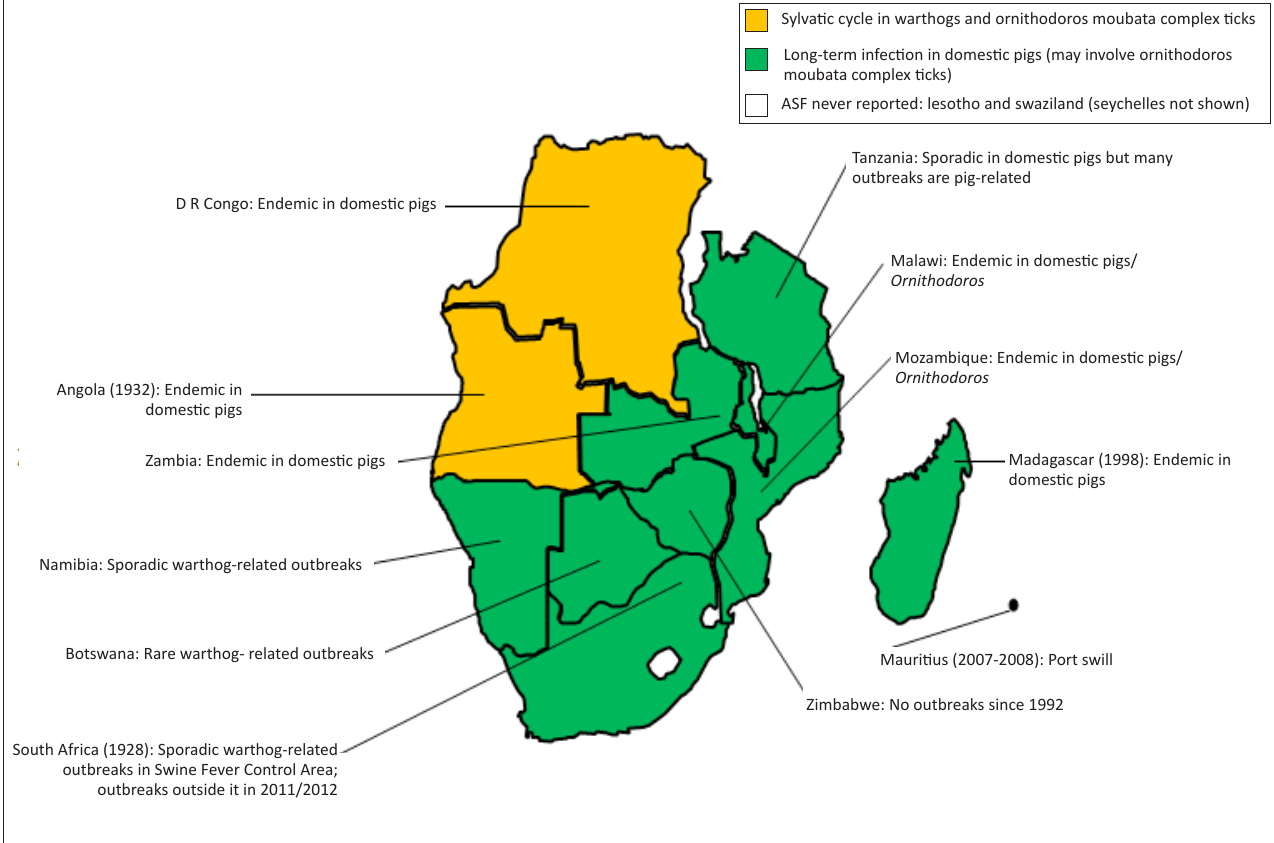
FIGURE 1: African swine fever in countries of the Southern African Development